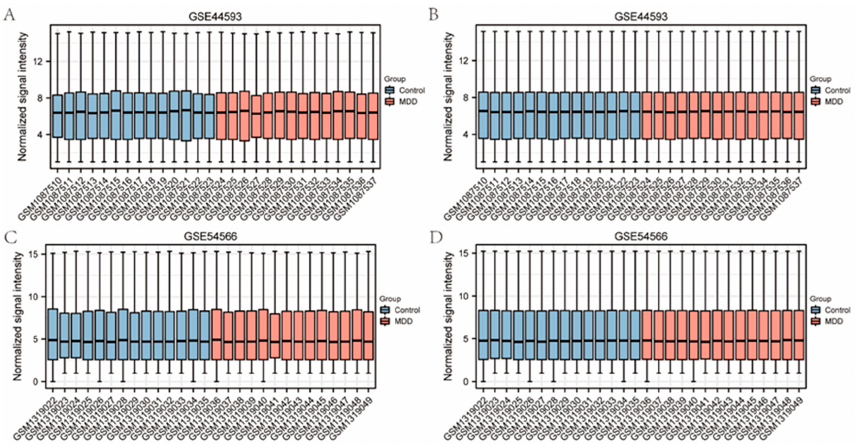
Figure 1. Boxplot before and after sample calibration for the GSE44593 dataset and the GSE54566 dataset. ( A , B ) Diagrams showing the data before and after sample correction to remove the inter-batch difference . ( C , D ).